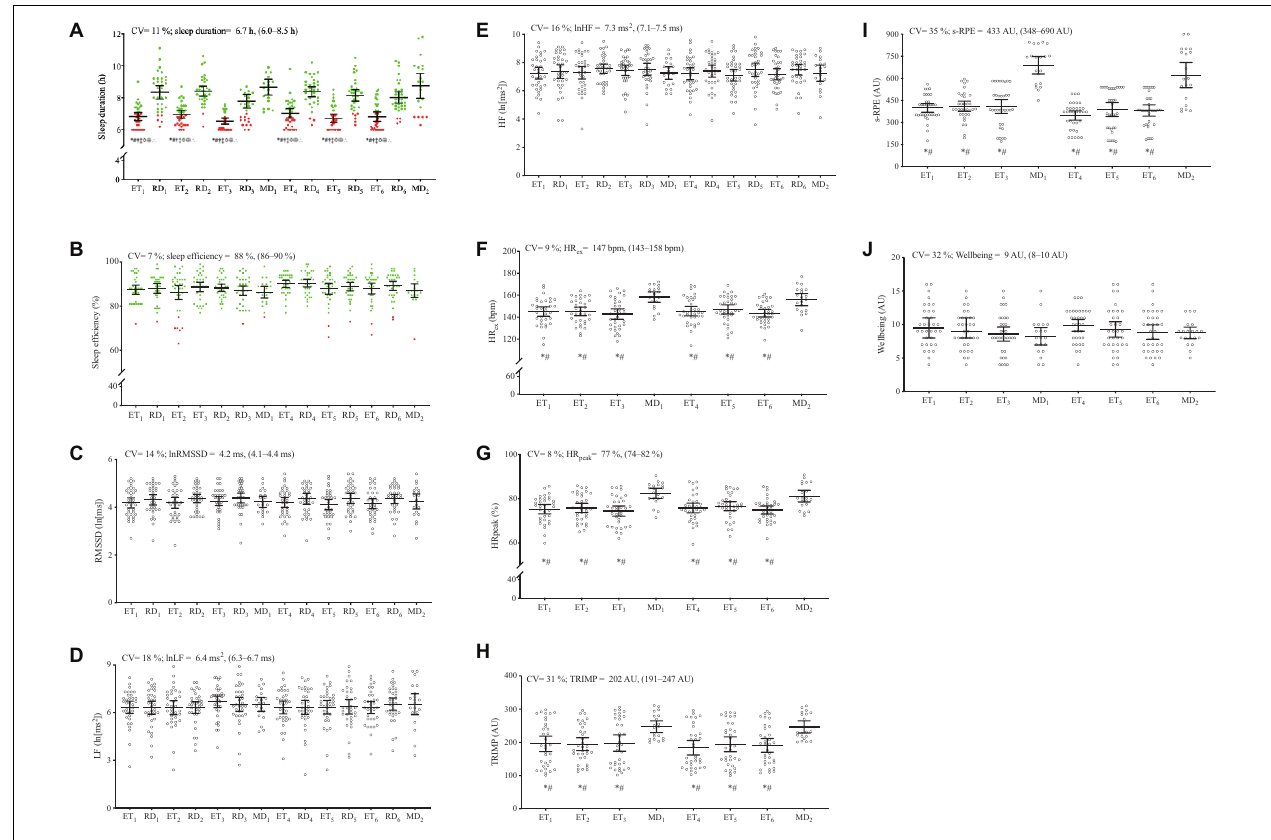
FIGURE 2 | Descriptive group data and individual ( n = 34) responsiveness for sleep (A,B) and nocturnal HRV indices (C–E) , training and match load parameters (F–I) , and perceived ratings of wellbeing (J) during 14 days of in-season competitive phase in high-level female soccer players. Horizontal black lines show group mean ± 95% confidence interval for each day. Coefficient of variation (CV), averages, maximum, and minimum values are also presented. Graph (A) and (B) : The red dots represent the days where sleep duration and sleep efficiency were lower than the recommended amounts (i.e., sleep duration < 7 h and sleep efficiency < 75%), respectively. The green dots represent the days where sleep duration and sleep efficiency were considered as recommended. *Significantly different from MD 1 . # Significantly different from MD 2 . † Significantly different from RD 1 . ‡ Significantly different from RD 2 . (cid:5) Significantly different from RD 3 . ∴ Significantly different from RD ⊕ Significantly different from RD ∅ Significantly different from RD 5 . 4 . 6 . ET, evening-time training sessions; RD, rest-days; MD, match-days; lnRMSSD, logarithm of the root mean square of successive R-R intervals; lnLF, natural logarithm of low frequency; lnHF, natural logarithm of high frequency; HR ex , the average heart rate during exercise; HR peak , peak heart rate; TRIMP, training impulse; s-RPE, session-rating of perceived exertion; AU, arbitrary